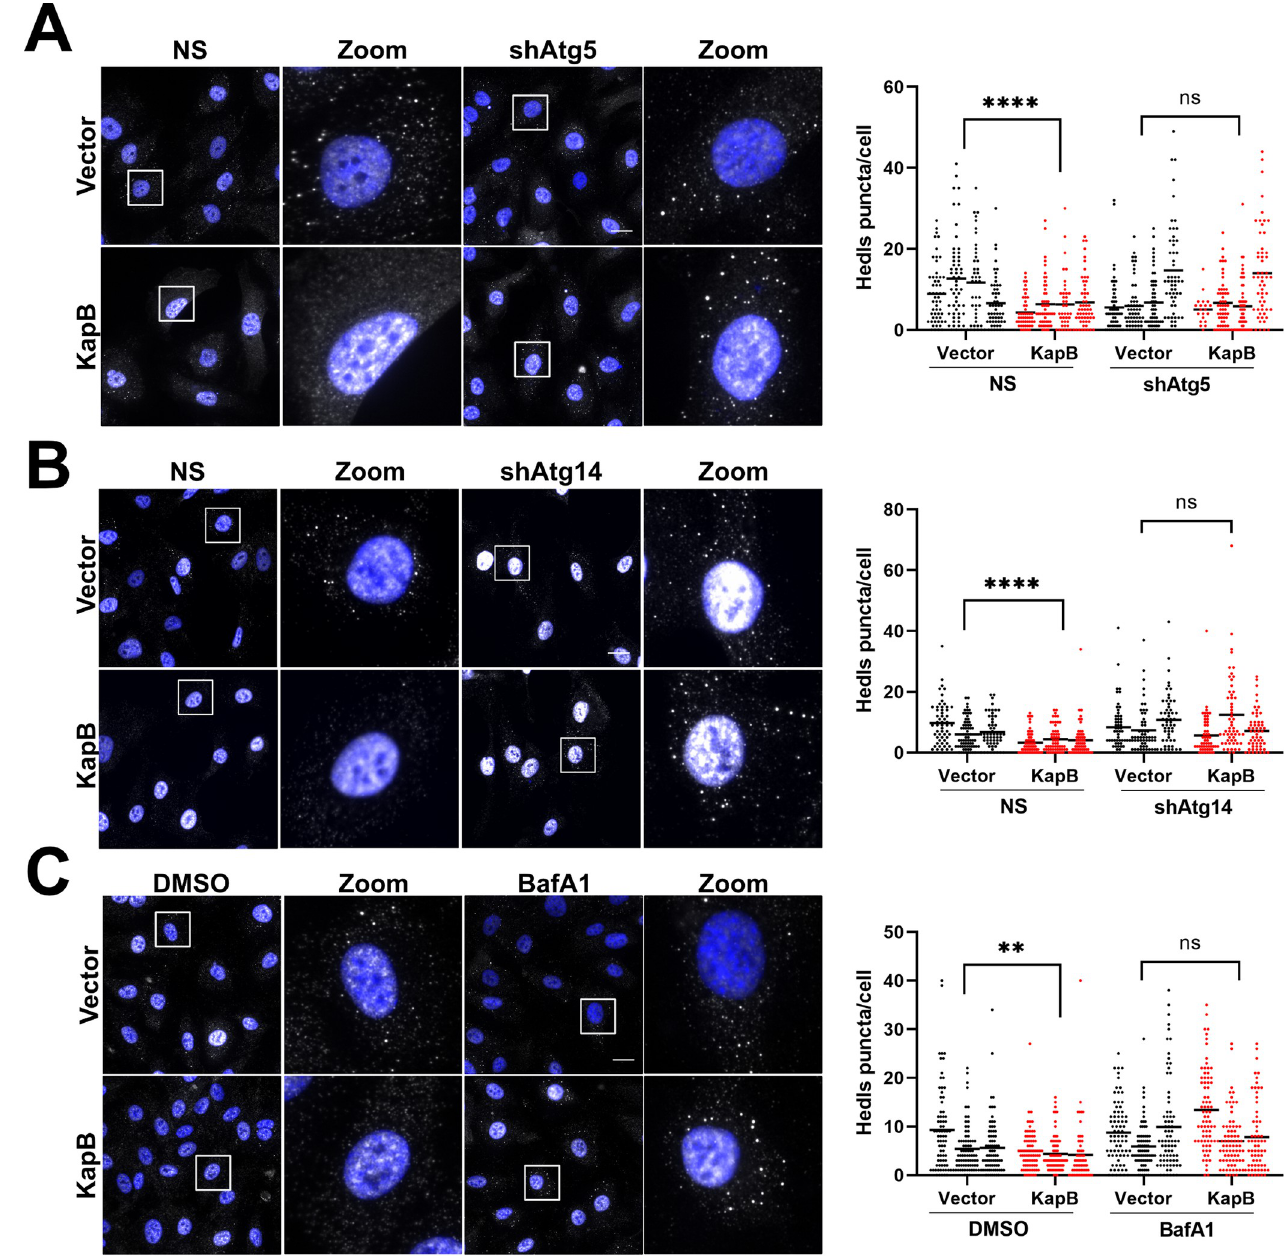
Fig 2. Kaposin B requires Atg5 and Atg14 autophagy to disassemble PBs. A & B: HUVECs were sequentially transduced: first with recombinant lentiviruses expressing either shRNAs targeting Atg5 (A) or Atg14 (B) (shAtg5, shAtg14) or a non-targeting control (NS) and selected with puromycin (1 μ g/mL), and second with either KapB or an empty vector control and selected with blasticidin (5 μ g/mL). Coverslips were fixed in 4% paraformaldehyde, permeabilized in 0.1% Triton X-100, and immunostained for the PB-resident protein Hedls (white) and nuclei (DAPI). Scale bar = 20 μ m. Hedls puncta were quantified using CellProfiler and presented as number of Hedls puncta per cell, all cells counted are displayed. Results were plotted in GraphPad and a 2-way ANOVA was performed on the main column effects with a Tukey’s multiple comparison test, bar represents the mean; n = 4 (A), n = 3 (B), ���� = P < 0.0001. C: HUVECs were transduced with recombinant lentiviruses expressing either KapB or an empty vector control and selected with blasticidin (5 μ g/mL). Cells were treated with BafA1 for 30 min, fixed in 4% paraformaldehyde, permeabilized in 0.1% Triton X-100, and immunostained for the PB-resident protein Hedls (white) and nuclei (DAPI). Scale bar = 20 μ m. Hedls puncta were quantified using CellProfiler and presented as number of Hedls puncta per cell, all cells counted are displayed. Results were plotted in GraphPad and a 2-way ANOVA was performed on the main column effects with a Tukey’s multiple comparison test, bar represents the mean; n = 3, �� = P <